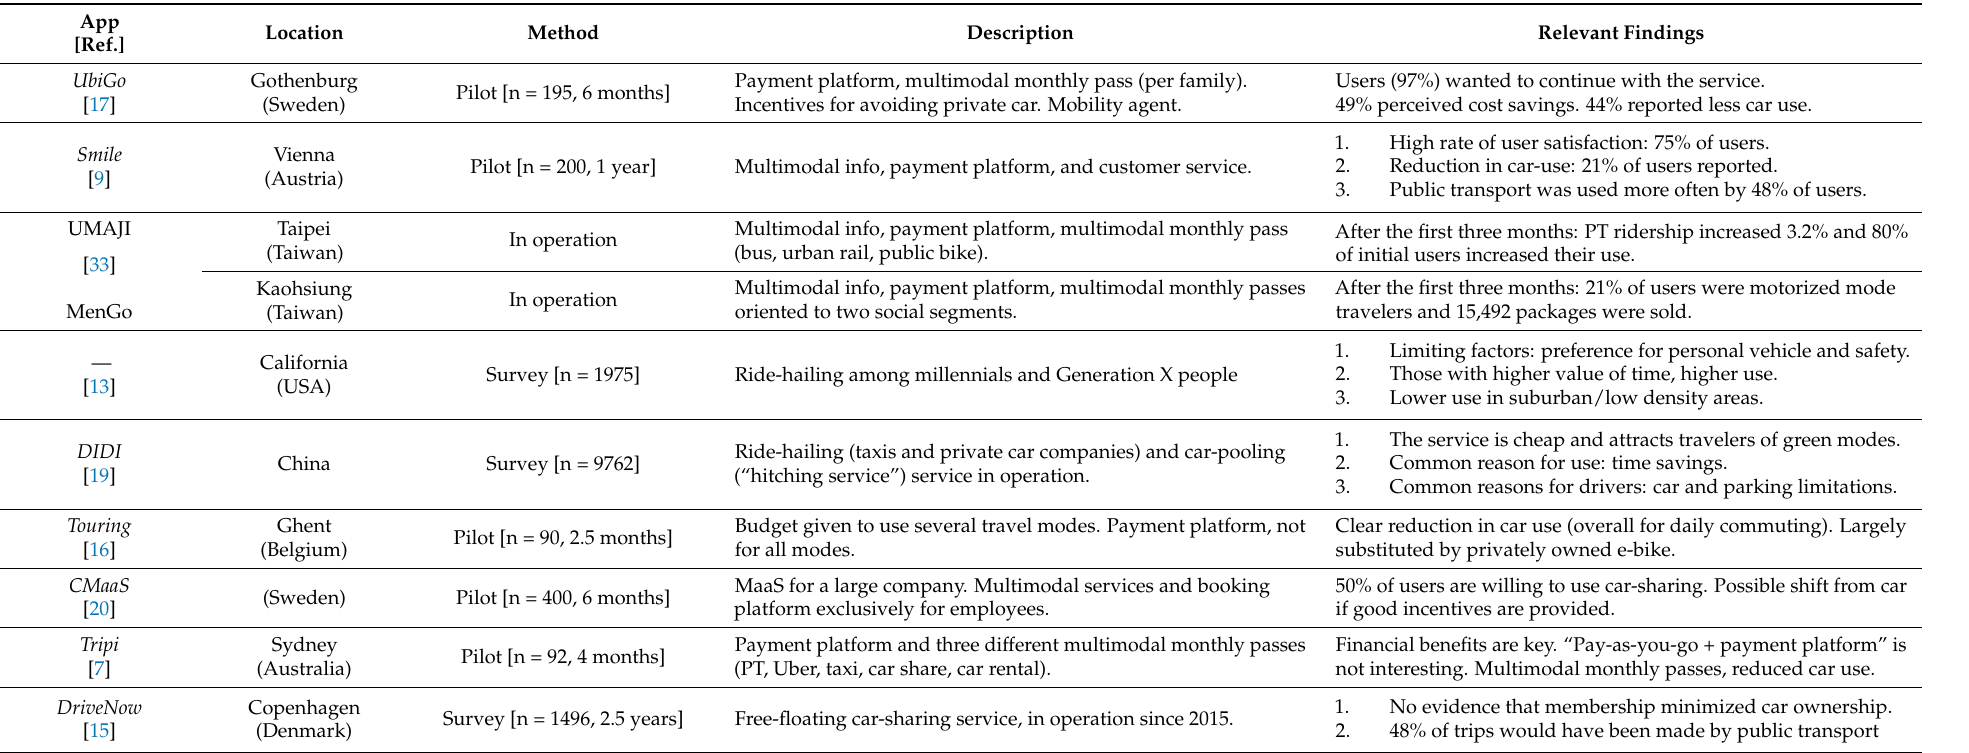
Table 1. Scientific studies on urban travel apps, real or experimental. Extracted from Appendix